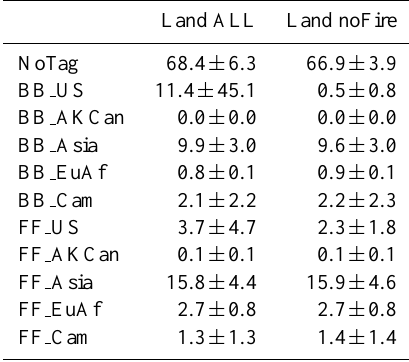
Table 5. Average CO Source Contributions for AVG RegionTime Land and the 2–8km altitude range. Units areppbV